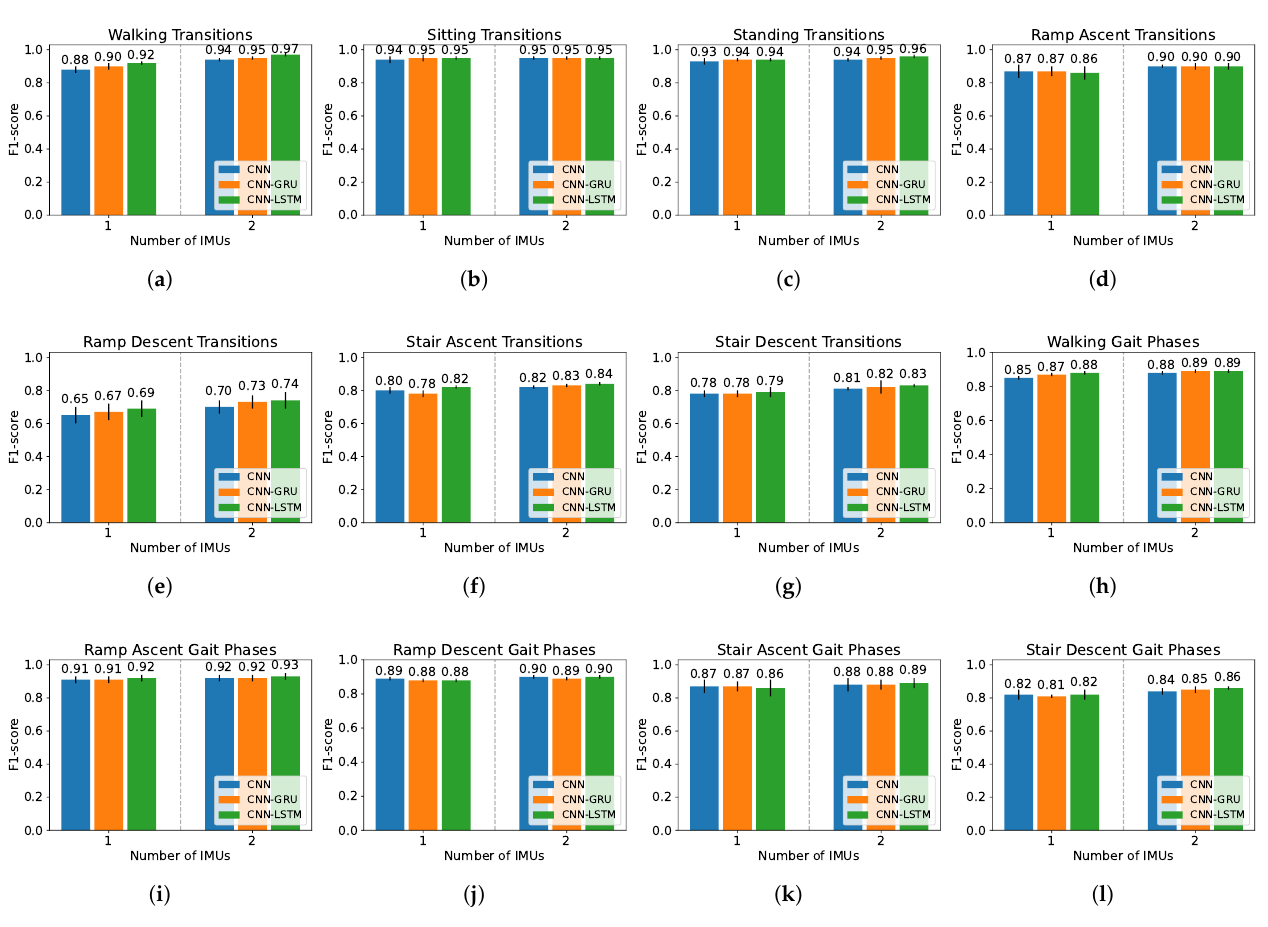
Figure 9. F 1-score of the different network architectures for one and two IMUs for the classification tasks of level 2. ( a ) Walking Transitions; ( b ) Sitting transitions; ( c ) Standing transitions; ( d ) Ramp ascent transitions; ( e ) Ramp descent transitions; ( f ) Stair ascent transitions; ( g ) Stair descent transitions; ( h ) Walking gait phases; ( i ) Ramp ascent gait phases; ( j ) Ramp descent gait phases; ( k ) Stair ascent gait phases; ( l ) Stair descent gait